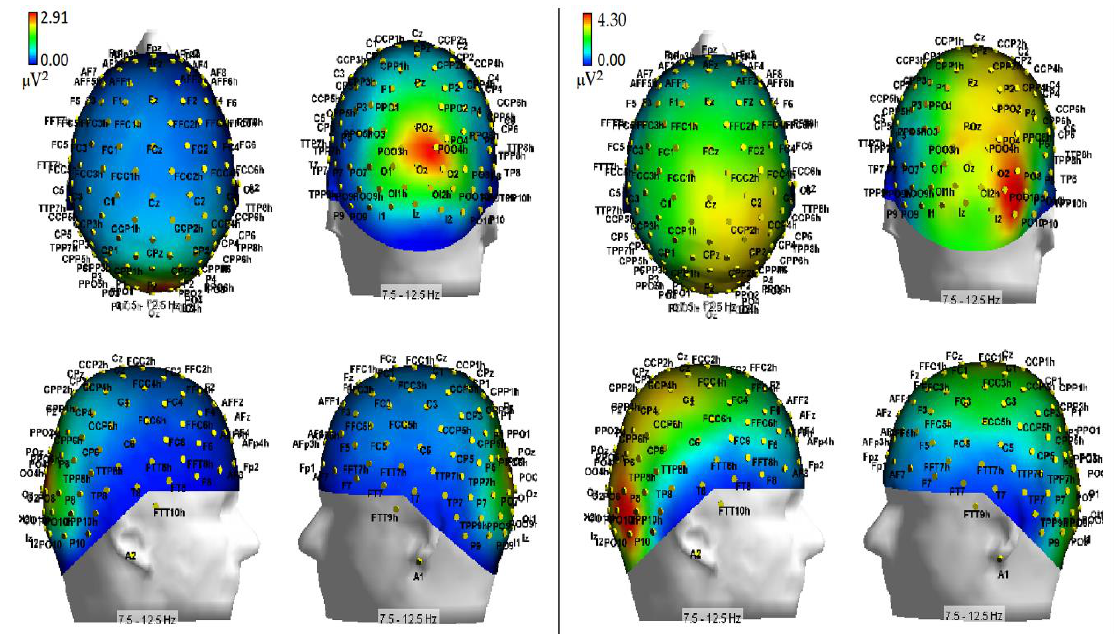
Figure 7. 3D topographical scalp maps of alpha power as a function of normoxia (left side) and hypoxia (right side) respiratory conditions grand-averaged across the attentional-cueing modes, and drawn from the top, the back, the right, and the left viewpoints, respectively. Worth of note is the prominent lateralization of alpha synchronization induced by hypoxia over the right-sided occipital and parietal scalp areas as compared to normoxia.